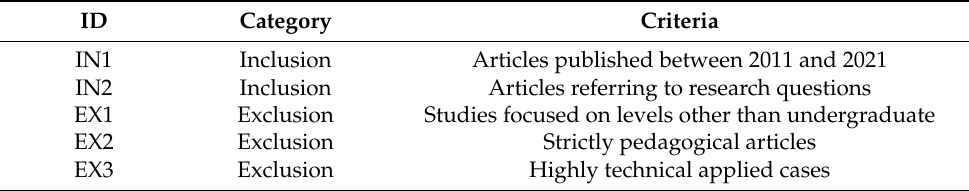
Table 3. Study selection criteria for this review.